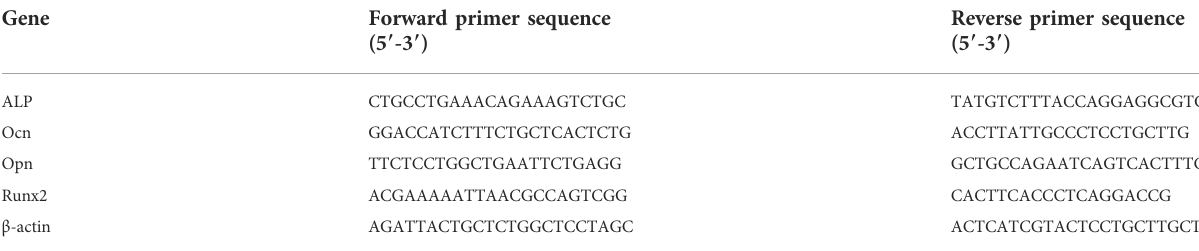
TABLE 1 The primers sequences used for